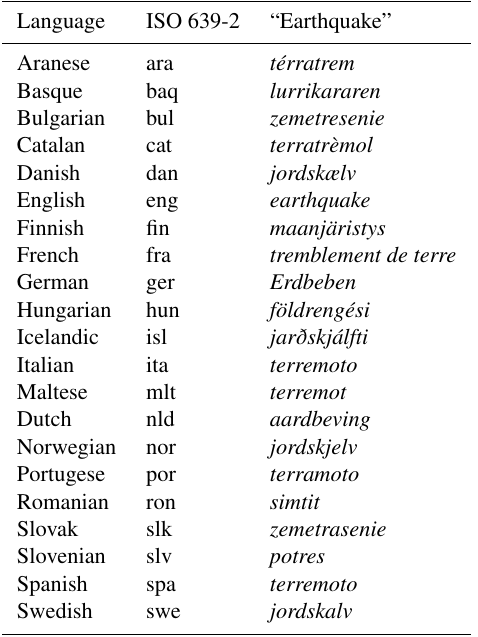
Table B1. Abbreviated languages. The translations for the word “earthquake” are used to find internet inquiries online. Abbreviated languages follow the international three-letter alpha-3/ISO 639-2